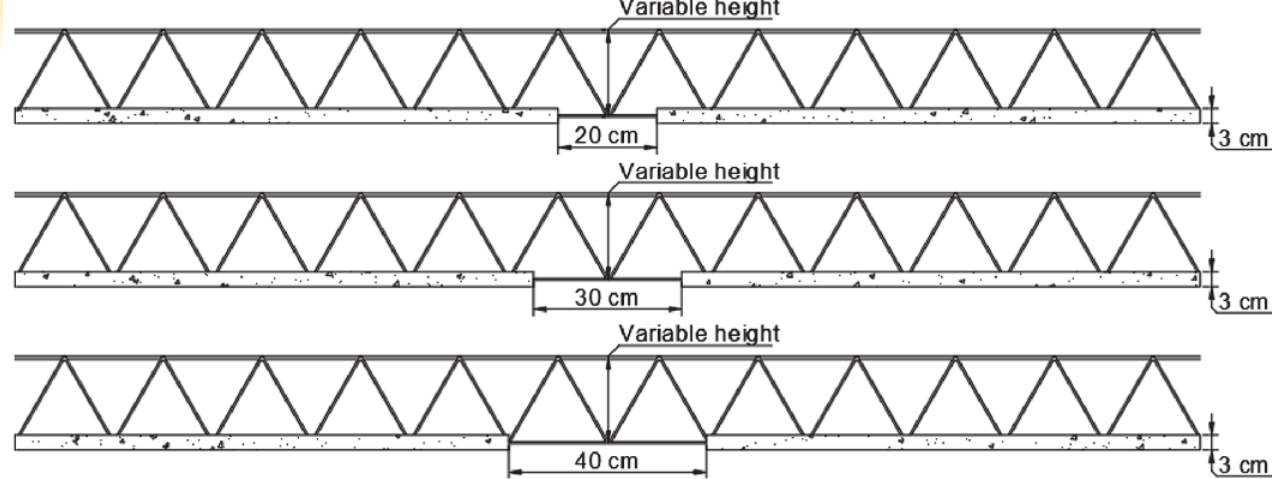
Longitudinal section of the lattice joists models with total length of 240 cm. The concrete opening in the central region in indicated